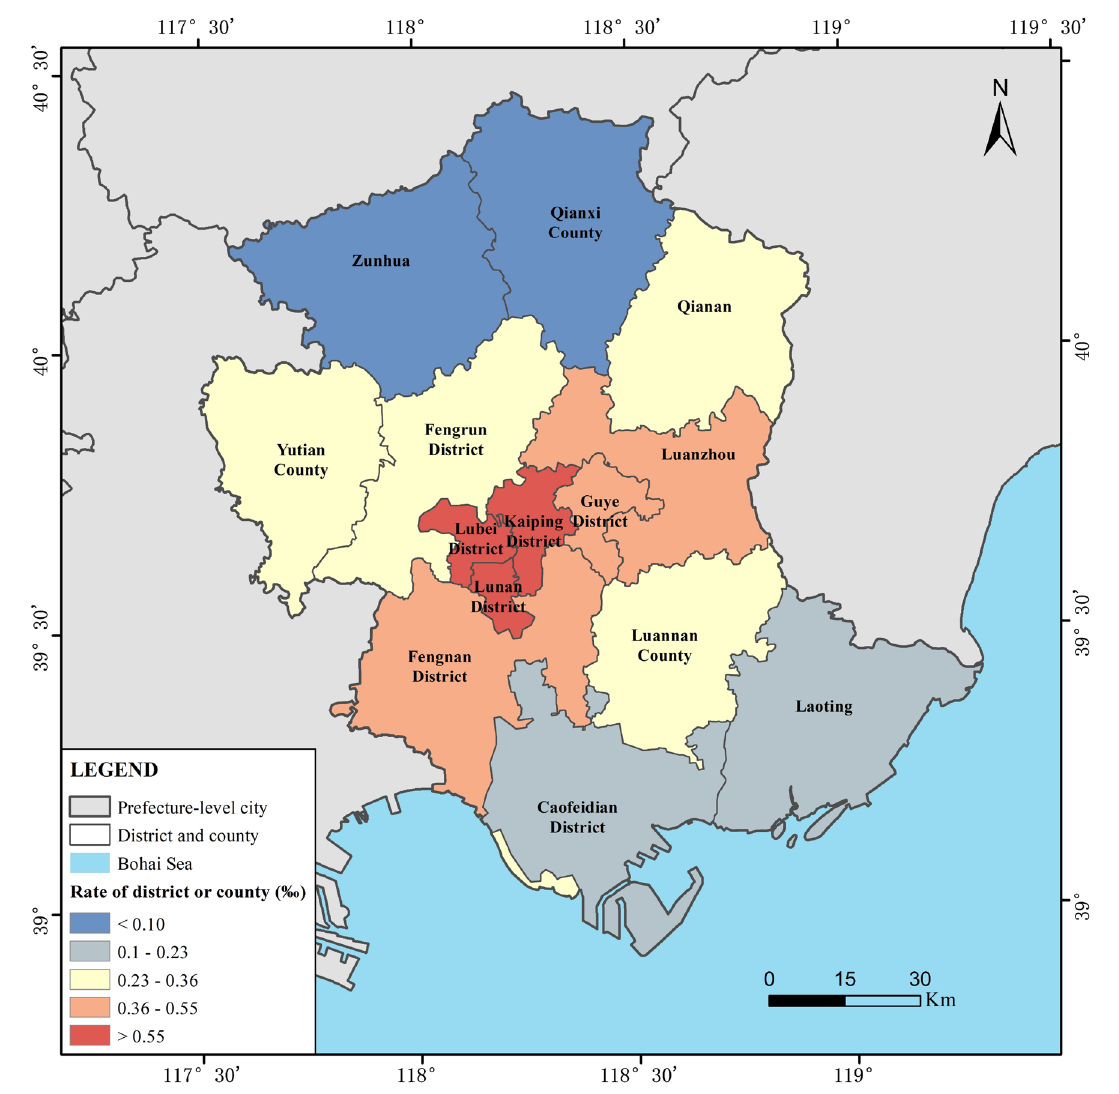
Fig. 4 Rate distribution by districts and counties in Tangshan